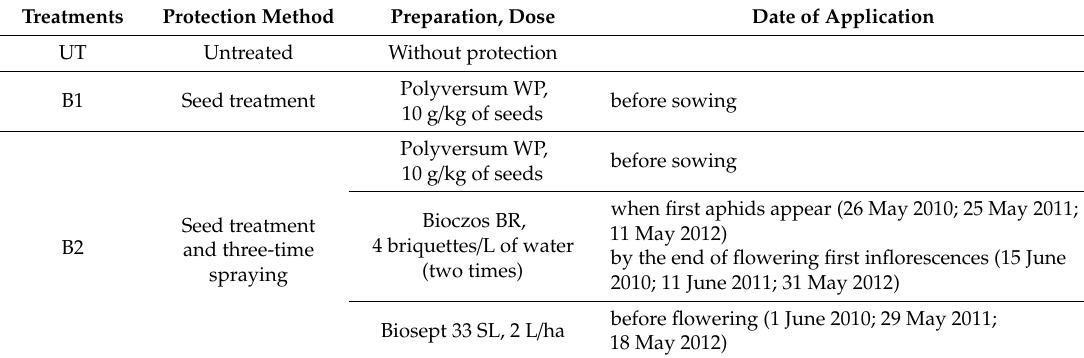
Table 1. Scheme of protection of broad bean against pest and